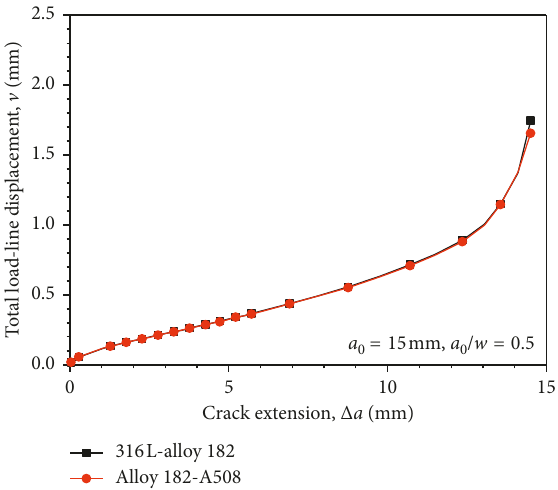
Figure 14: Applied displacement-crack extension curve at different interfaces of DMW joints.